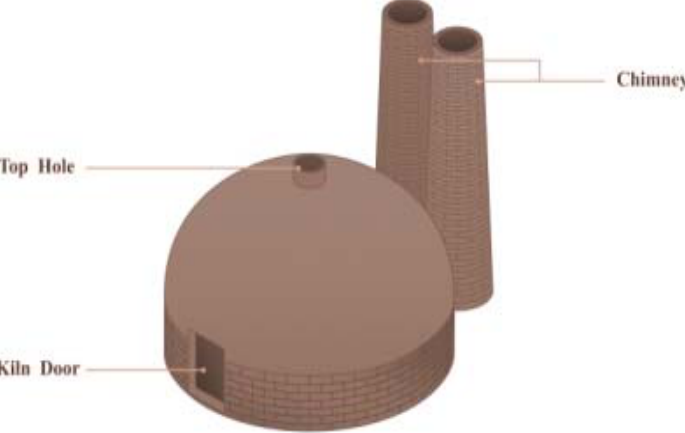
Figure 3. External view of Steamed Bun Kiln.